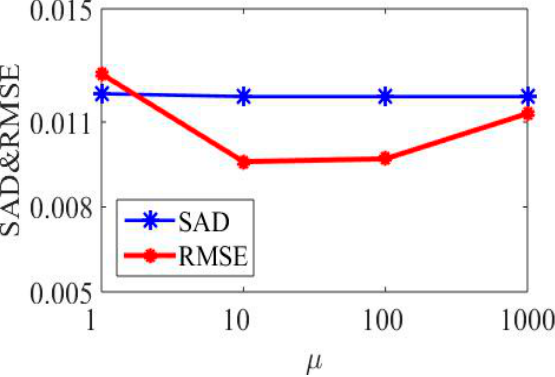
Figure 4. Performance of SSC-NMF with respect to parameter µ in terms of SAD and RMSE.